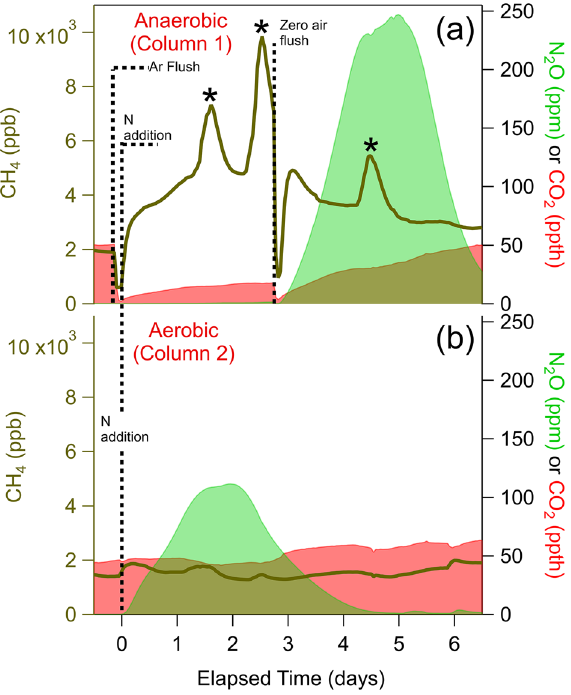
Figure 4. Response of soil N 2 O (shaded green, ppm), CH 4 (brown line, ppb), and CO 2 (shaded red, parts per thousand) concentrations to inorganic nitrogen addition (day 0) under ( a ) anaerobic and ( b ) aerobic conditions. The anaerobic column was maintained under Argon until an ultra zero air flush on day 3 (Supplemental Table S1). “Hot moments” of CH 4 are marked with